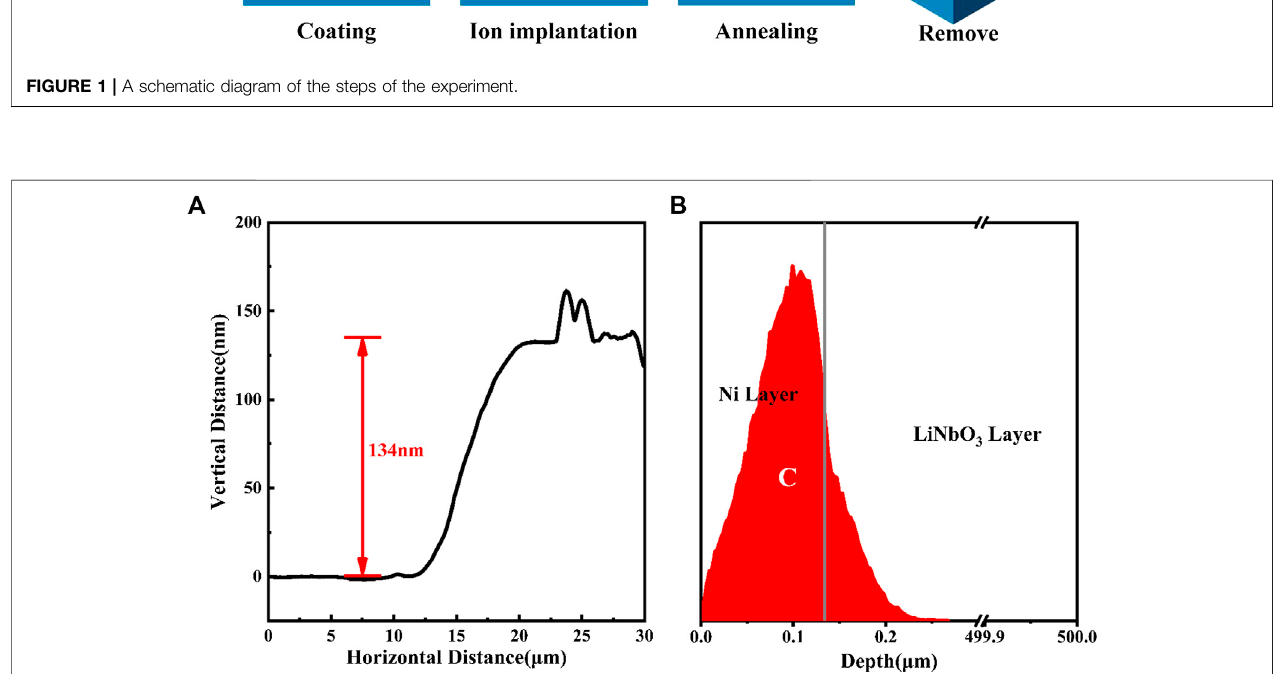
FIGURE 2 | (A) AFM height pro fi les along the straight line from uncoated notch to the coated area (B) Structural schematic diagram of the coated bulk LN crystal with the distribution of carbon ions along with the depth pro fi les, simulated by SRIM.